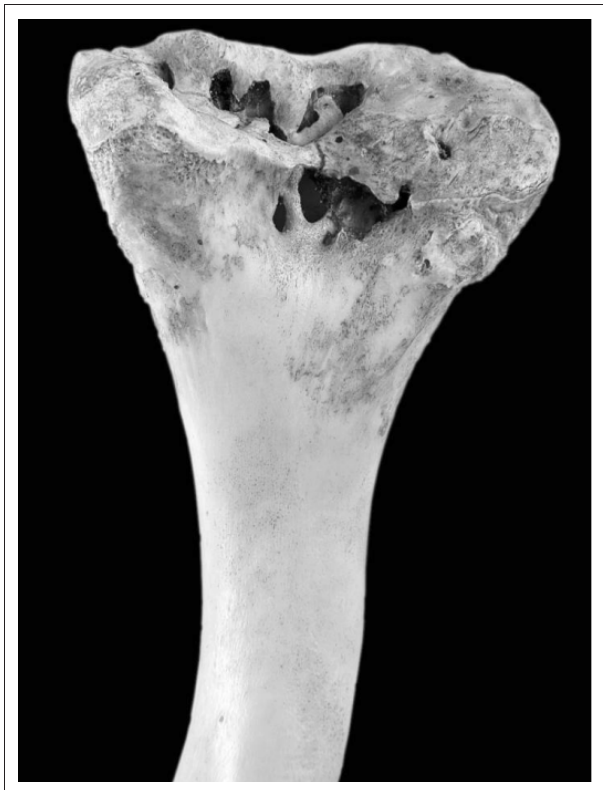
FIGURE 2: Nile crocodile humerus, case 1: Collapse of the distal articular surface.